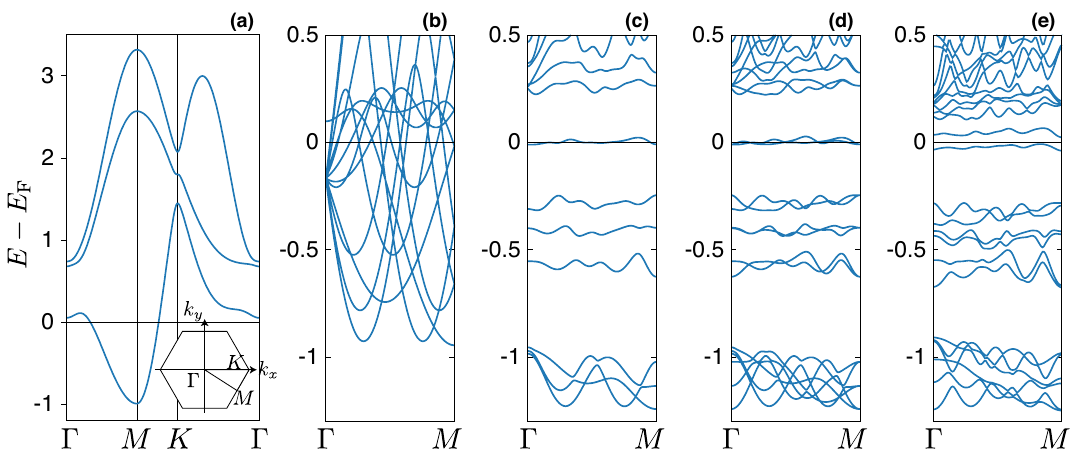
Figure 2. ( a ) band structure without PLD or Coulomb interaction. The inset schematically shows the Brillouin zone; ( b ) the same result with folded bands obtained by taking each hexagram as a unit cell; ( c ) band structure with PLD ( x = − 1.5) and no Coulomb interaction; ( d ) the same result shown with folded bands for two-hexagram unit cell; ( e ) band structure with both PLD ( x = − 1.5) and on-site Coulomb interaction ( U = 3 J = 0.816eV) calculated within mean-field approximation (6) at T =